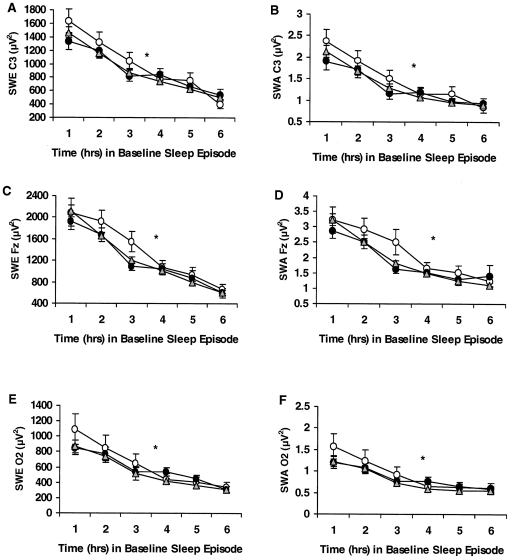
Hourly slow-wave energy (SWE) and slow-wave activity (SWA) during baseline for the COMT Val158Met genotypes.Mean (±SEM) hourly SWE and SWA derived from the C3 (A, B), Fz (C, D) or O2 (E, F) channels during baseline for Met/Met (open circles), Val/Met (gray triangles) and Val/Val (closed circles) subjects. As expected, SWE and SWA showed a typical pattern of dissipation across the baseline night in all 3 channels in all genotypes (denoted by *, p<0.0001), but did not show a differential pattern of decline across genotypes. The groups also did not show significant differences in SWE or SWA derived from the C3, Fz or O2 channels. In some records, EEG signal quality was insufficient or contained too much artifact for reliable power spectral analysis. Thus, the final sample sizes were as follows: for C3, Met/Met (n = 19), Val/Met (n = 60), and Val/Val (n = 39) subjects; for Fz, Met/Met (n = 18), Val/Met (n = 62), and Val/Val (n = 42) subjects; for O2, Met/Met (n = 19), Val/Met (n = 61), and Val/Val (n = 44) subjects.